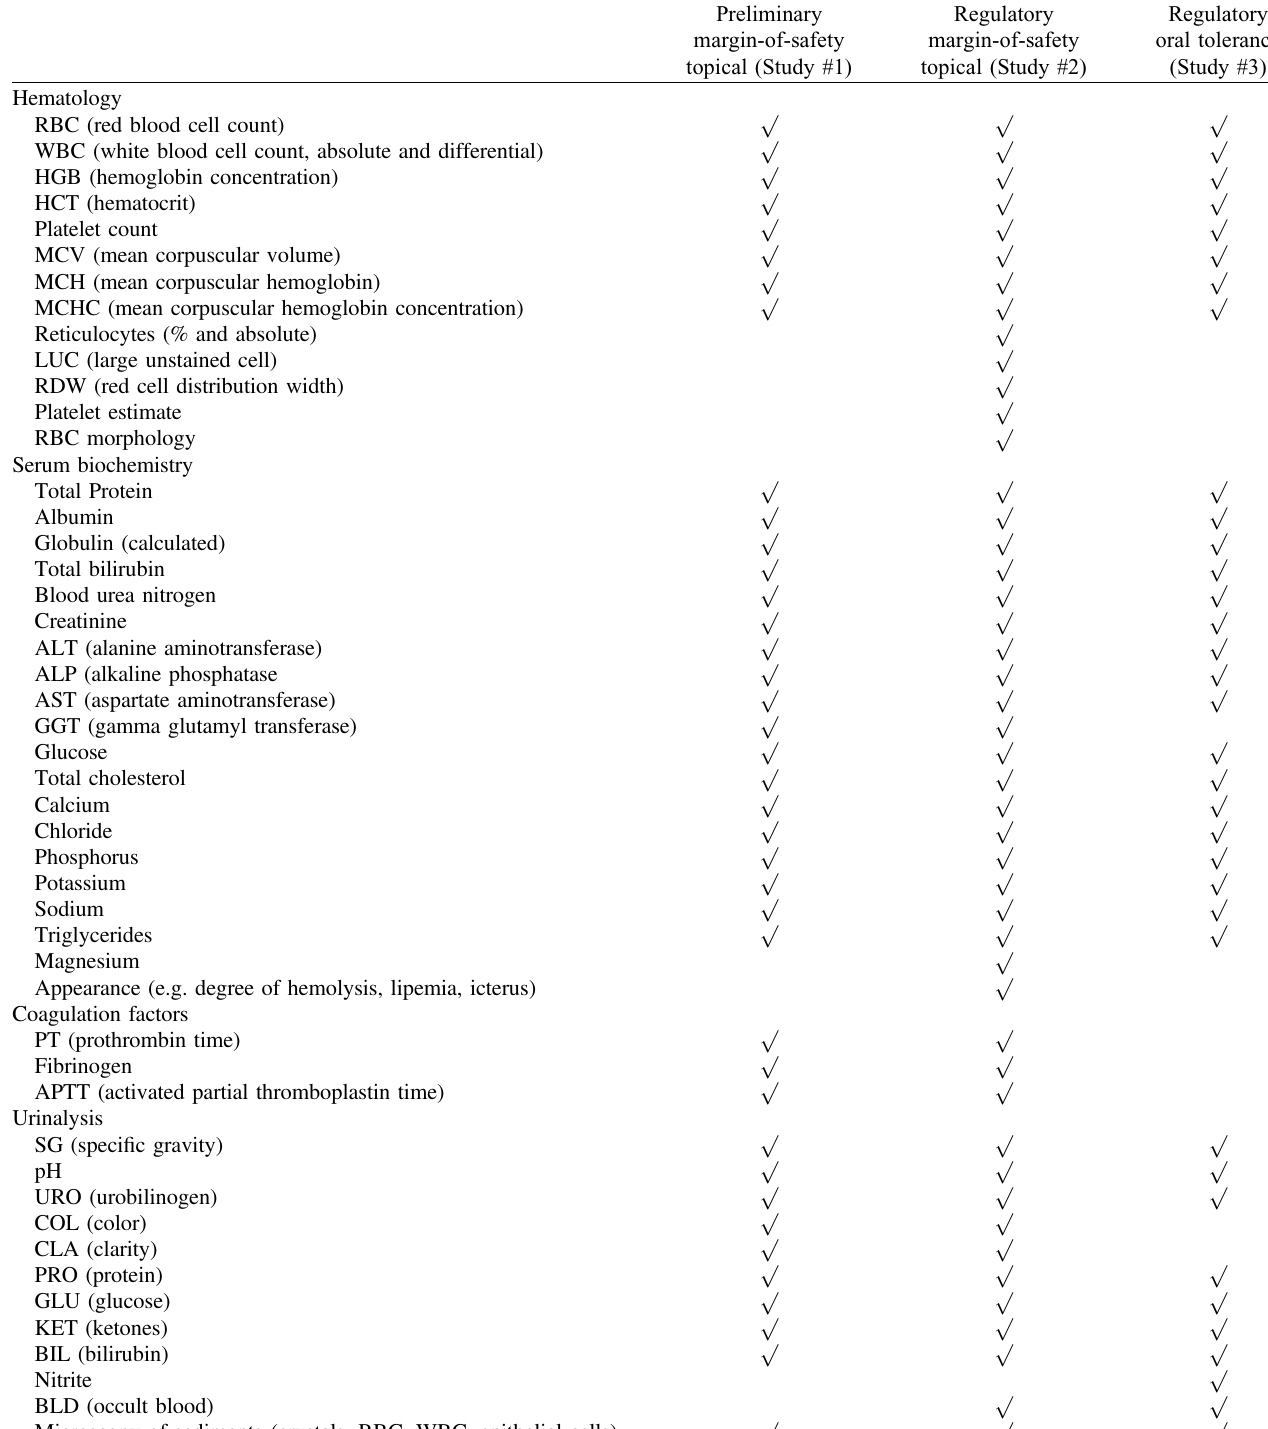
Table 2. Clinical pathology and histology